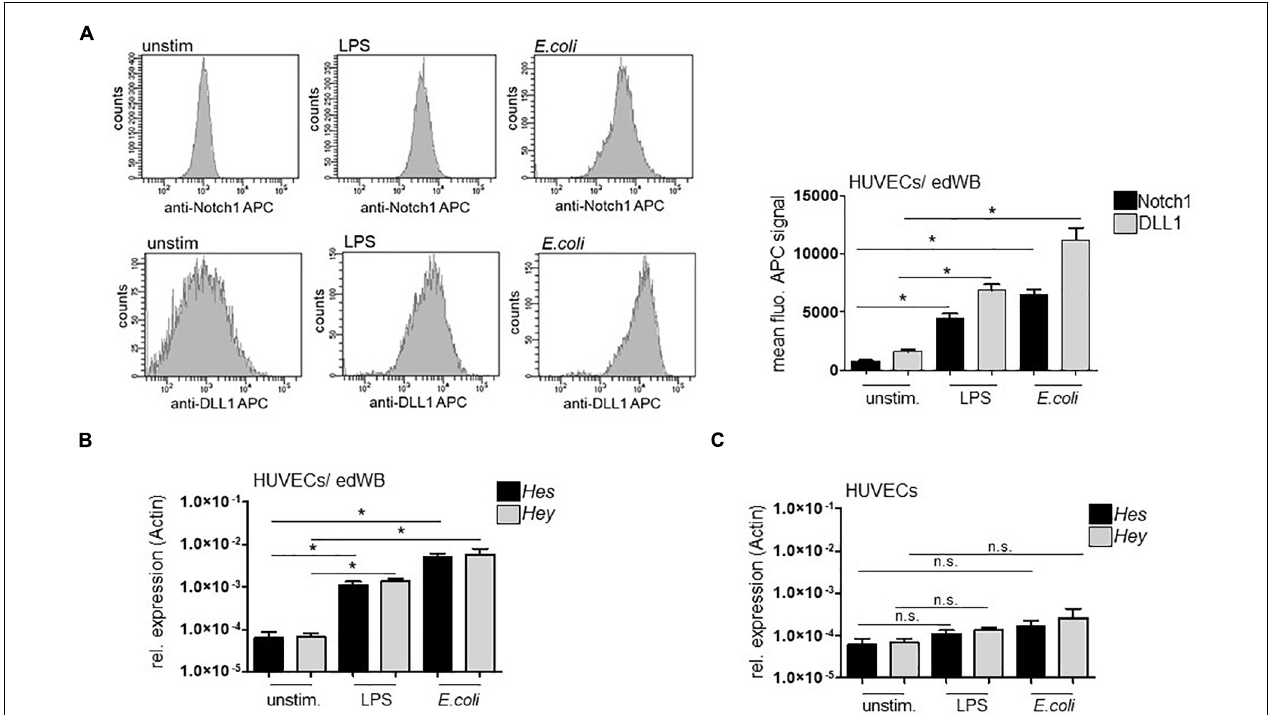
FIGURE 1 | Bacterial stimulation induces Notch1 receptor and DLL1 expression on HUVECs. The 3 × 10 4 HUVECs were seeded in collagen-coated transwells and grown for 8 days until they formed a monolayer. The 500 µ l erythrocyte-depleted whole blood (edWB) was added per well. The HUVECs/edWB coculture was stimulated with 100 ng/ml LPS or an E. coli strain (MOI 50) overnight. Then, edWB was removed via repeated washing of the endothelial monolayer with PBS. (A) HUVECs were harvested through trypsinization, stained with anti-Notch1 receptor antibody and anti-DLL1 antibody, and analyzed by flow cytometry. Left: Histograms of flow cytometry analysis. Right: Quantification of mean fluorescence of bound antibody. (B,C) RNA was isolated from HUVECs, previously cocultured with edWB (B) or without edWB (C) and cDNA was produced. Quantitative rt-PCR was performed with SYBR Green Rox Mix and sequence specific primers for Hes 1 and Hey 1. Gene expression was normalized against the actin housekeeping gene (relative expression). Data were analyzed using Prism9 software (mean ± standard deviation; n = 3) and significance was calculated using a one-sided Mann-Whitney U -test. * p ≤ 0.05, n.s. = not